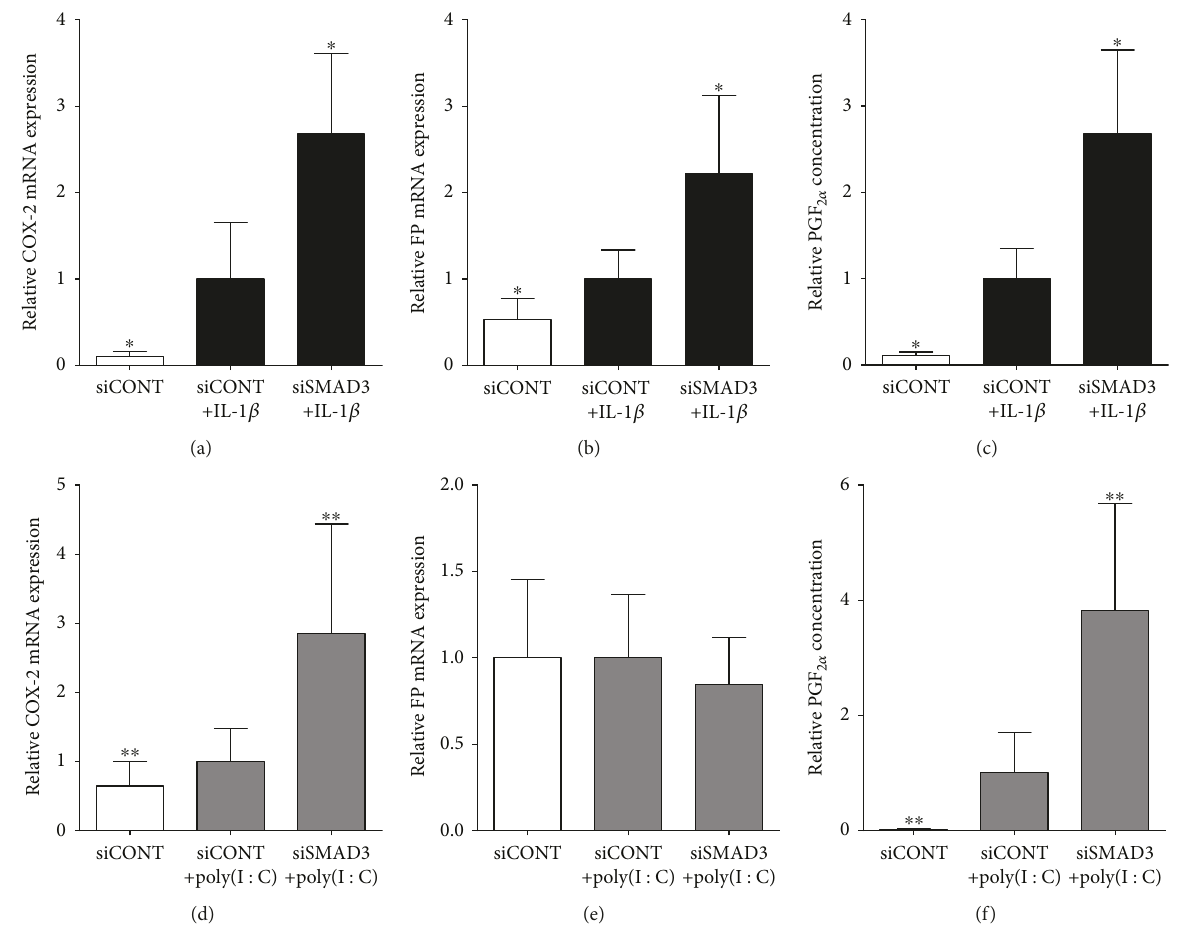
Figure 6: E ff ect of siSMAD3 on the COX-2-prostaglandin pathway. Human primary myometrial cells, obtained from women at term in the absence of labour, were transfected with or without 50 nM siSMAD3 or 50 nM siCONT for 48 h and then treated with (a – c) 1ng/ml IL-1 β or (d – f) 5 μ g/ml poly(I: C) for an additional 24h ( n = 5 patients). (a, c, d, e) Expression of COX-2 and FP mRNA was analysed by qRT-PCR. (c, f ) PGF concentration in the incubation medium was assayed by ELISA. For all data, the fold change was calculated relative to IL-1 β - or 2 α poly(I:C)-stimulated siCONT-transfected cells and displayed as mean ± SEM. ∗ P ≤ 0 05 vs. IL-1 β -stimulated siCONT-transfected cells (one-way ANOVA). ∗∗ P ≤ 0 05 vs. poly(I:C)-stimulated siCONT-transfected cells (one-way